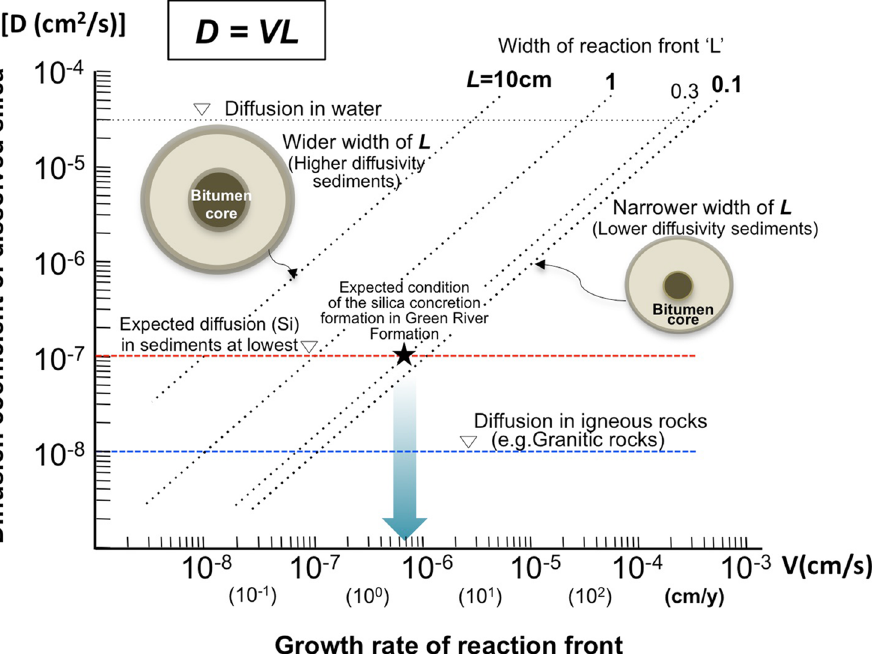
Figure 4. Diffusion–growth rate cross-plot. Relationship between effective diffusion coefficient (D; cm 2 /s) and rate of movement of the reaction front (V; cm/s) defined by dimension analysis. The field over which the silica concretions most likely formed is defined by the width of the reaction front (L = 0.3 cm) and the effective diffusion coefficient of SiO 2 (aq) in similar kinds of marine sediments 60,61 . A very rapid minimum growth rate of the reaction front, in the order of 10 −6 cm/s, is consistent with the formation of cm sized concretions within 10